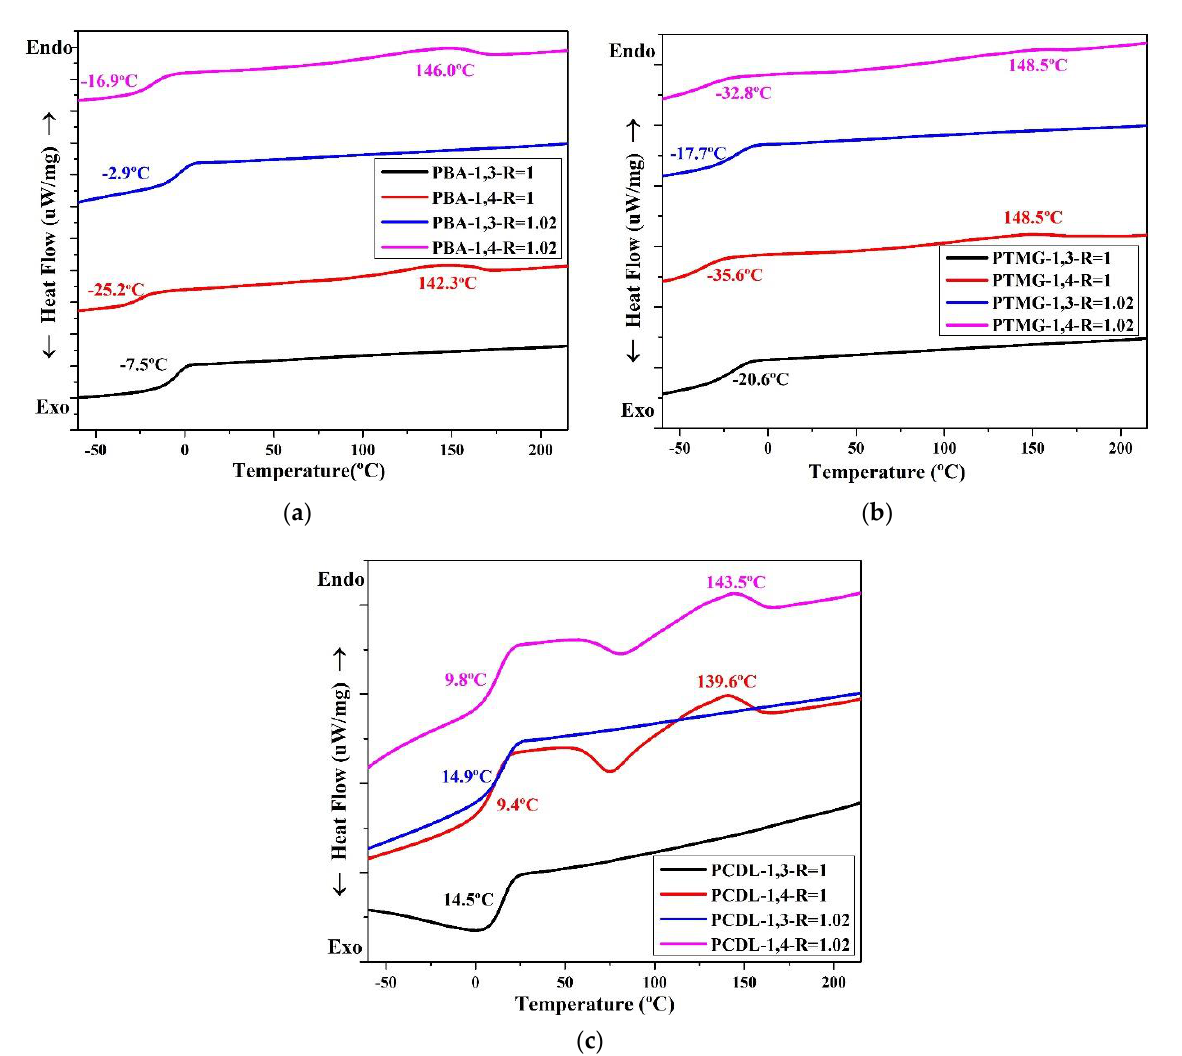
Figure 3. Differential scanning calorimetry (DSC) thermograms of TPU formed through the polymerization of PBA ( a ), PTMG ( b ), or PCDL ( c ), with 1,3-BDO or 1,4-BDO.